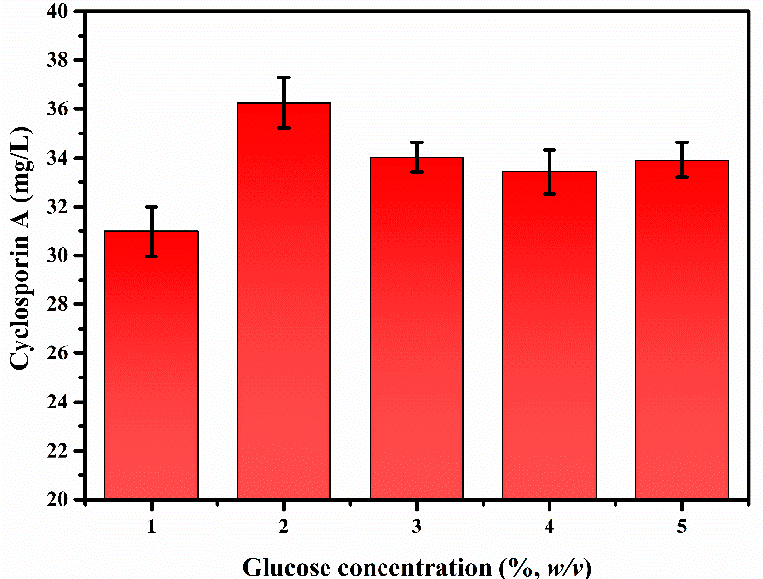
Figure 3. Effect of glucose concentration on cyclosporin A production by Tolypocladium inflatum ATCC 34921.